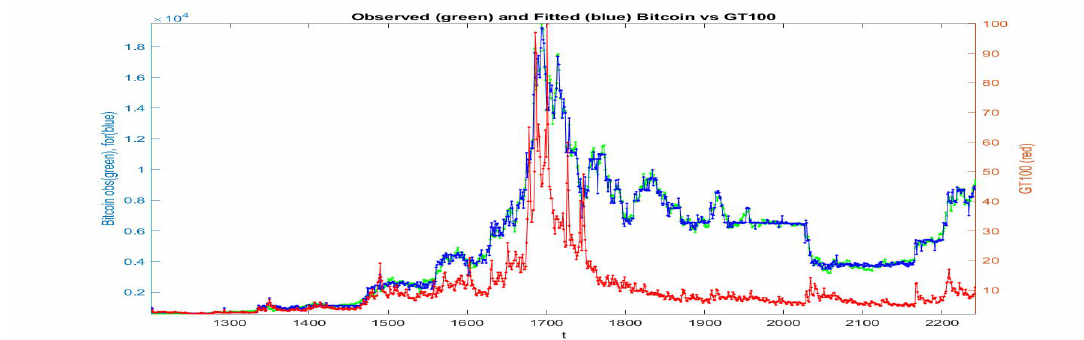
Figure 12. Clustering C: the fitted Bitcoin time series (blue color) is obtained from L 2 -norm iF-transform function applied to the data-set ( GT 100 t , Bitcoin t ) ; the observed Bitcoin t values are green and the observed GT 100 t values are red.